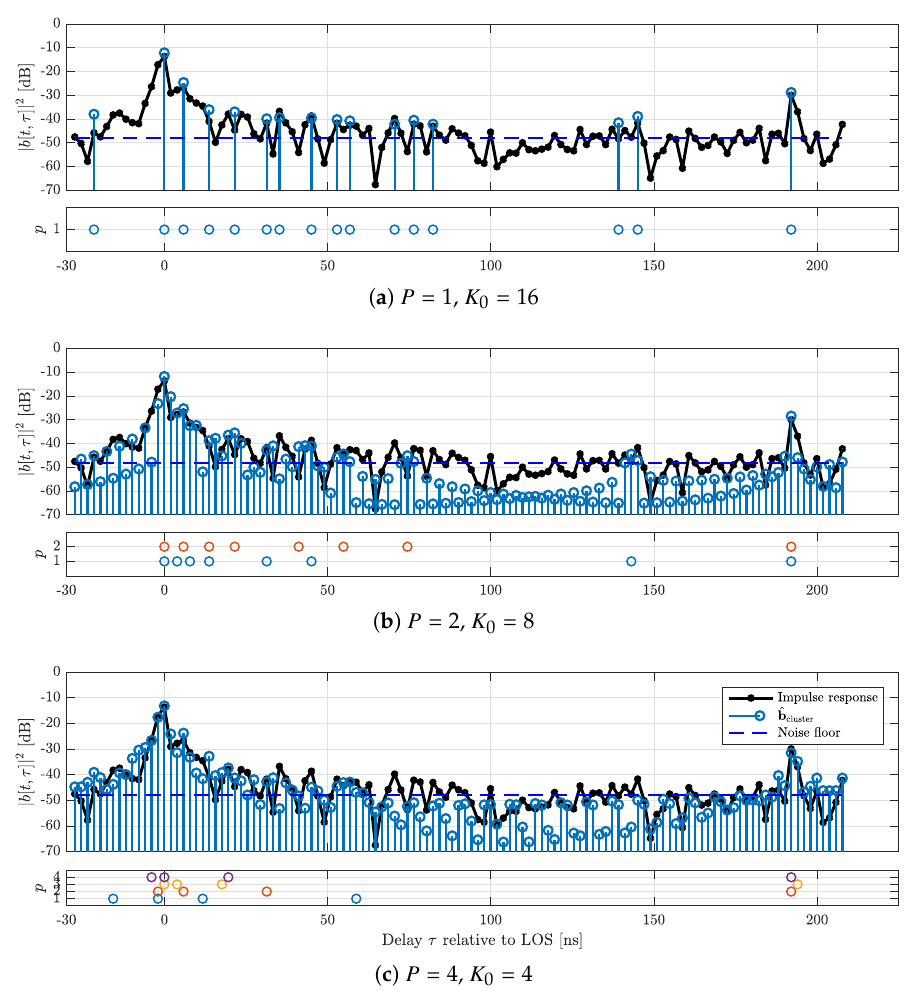
Figure 8. Sample impulse responses, estimated cluster impulse responses and cluster locations for M = 16 and P ∈ { 1,2,4 } (( a ); ( b ); and ( c